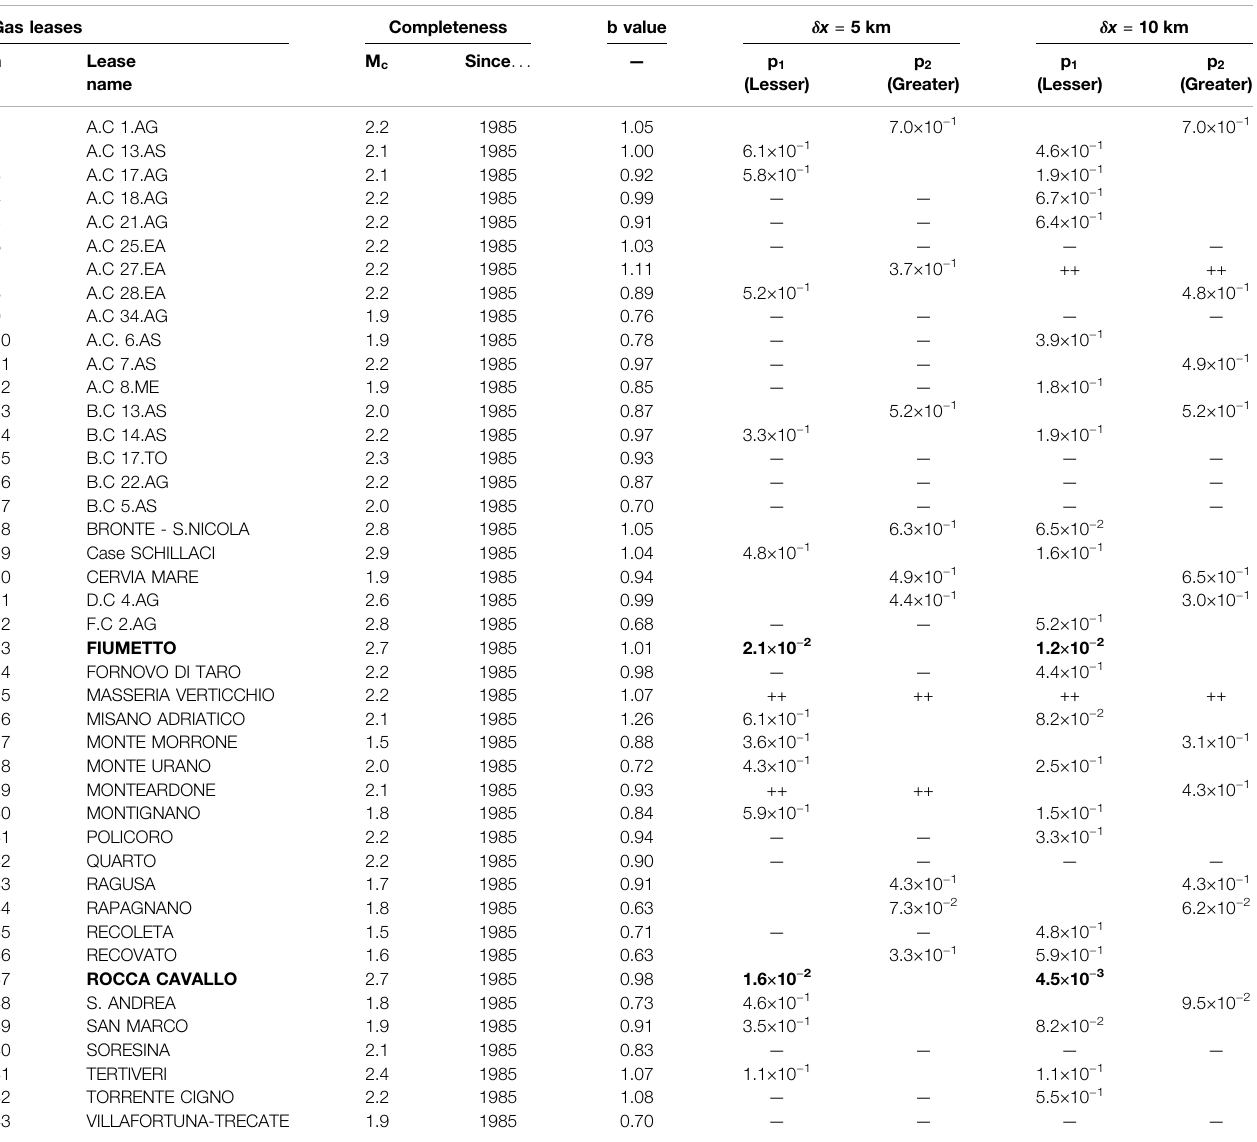
Bold values represent the cases in which the obtained p value is considered signi fi cant (respect to the s.l. taken as